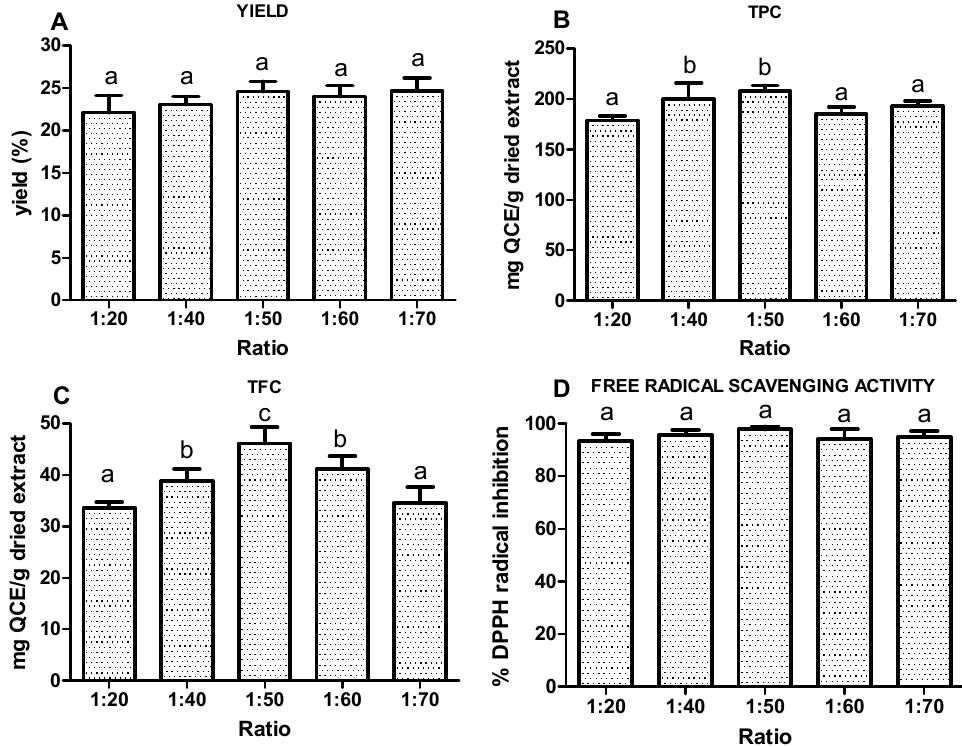
Figure 3. Effect of solid-to-liquid ratio on the extraction % yield ( A ), TPC ( B ), TFC ( C ), and DPPH free radical scavenging activity ( D ) from OPLs. Different letters indicate significant difference between tested parameters ( p < 0.05).